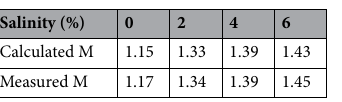
Table 5. Comparison between calculated and measured stress ratio.